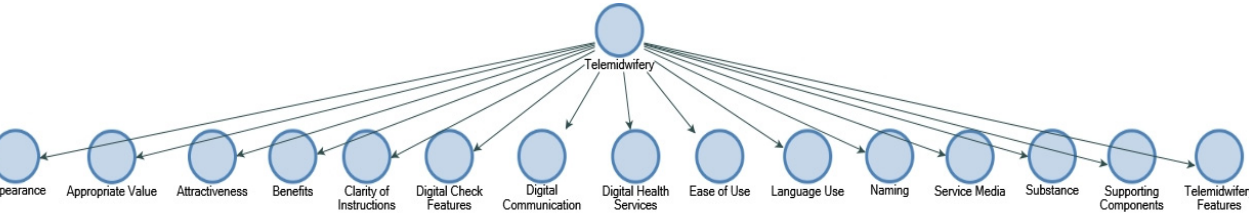
Figure 2. Visualization of Major Themes in Telemidwifery.